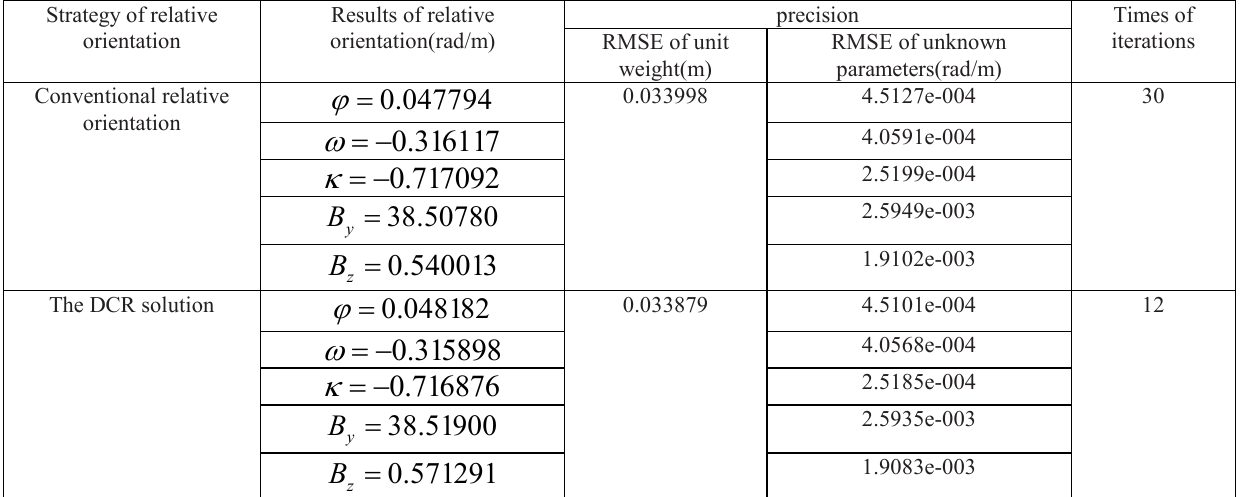
Table 2. Results of relative orientation obtained by the second experiment